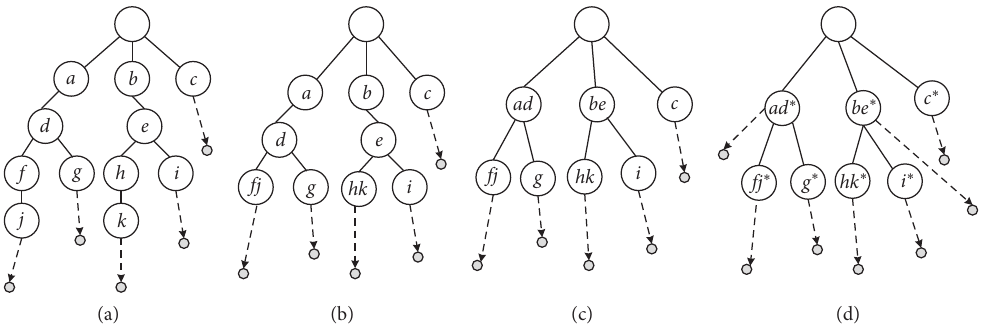
Figure 5: Sample of ATree optimization. (a) Original, (b) leaf compression, (c) node compression, and (d)